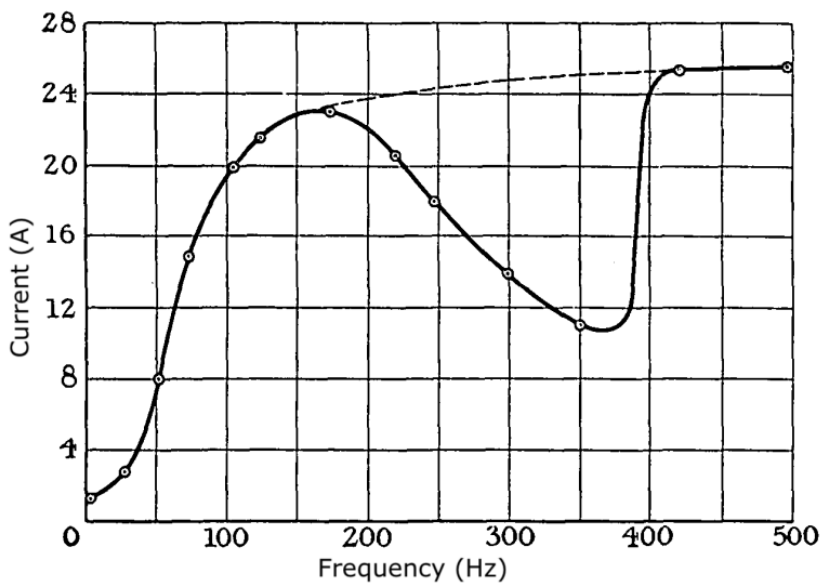
Figure 3. The effect of frequency on the current needed to ignite a methane/air mixture with a 200 V power supply, as reported by Thornton [31] .